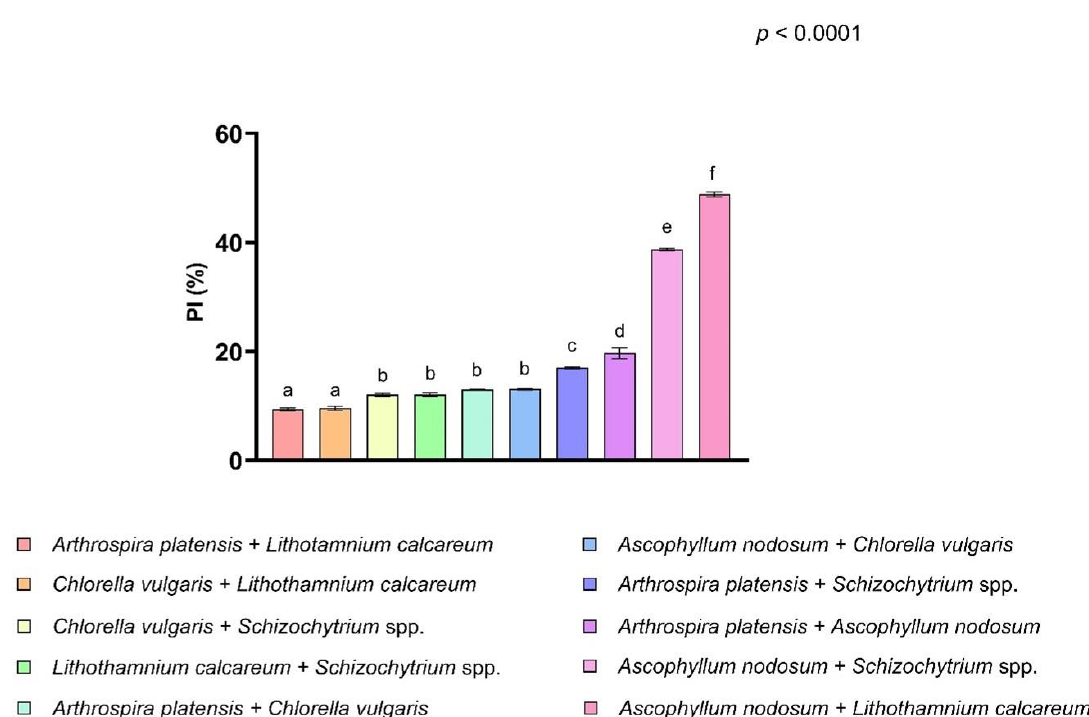
Figure 2. Antioxidant activity of algae and cyanobacteria combination. Figure shows the percentage of inhibition (PI%) of all the possible combinations between the species analyzed. Data are shown as means and standard deviations. All the combinations are significantly different compared to the combination of Ascophyllum nodosum extract and Lithothamnium calcareum extract. Data are shown as means and standard deviations. a, b, c, d, e, f Means ( n = 3) with different superscripts are significantly different (Treatment p < 0.0001).